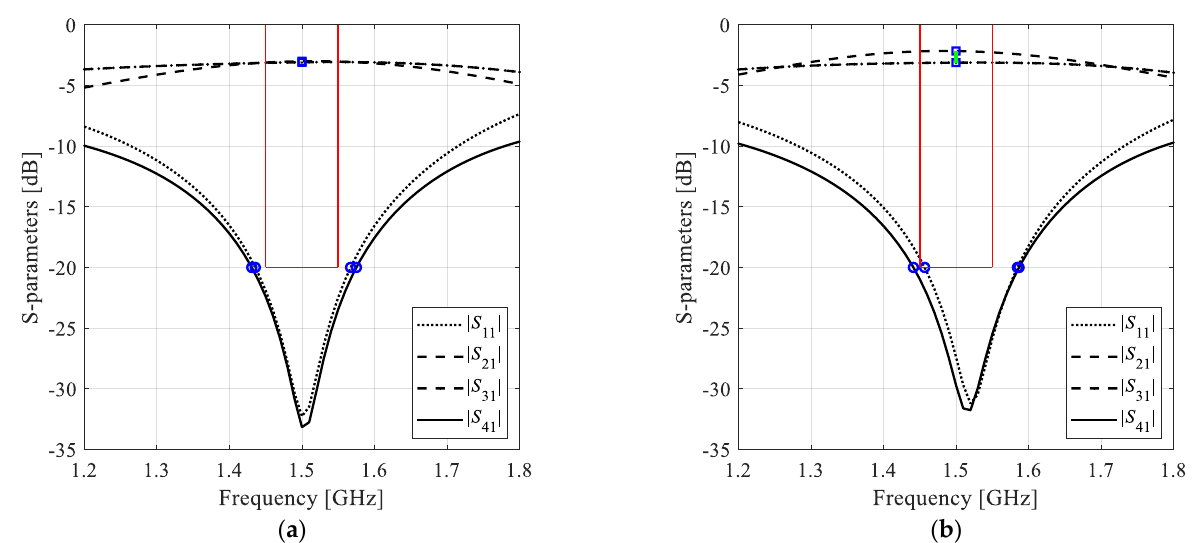
Figure 1. Scattering parameters of an exemplary microwave coupler along with the response features corresponding to –20 dB level of matching (| S 11 |) and isolation (| S 41 |) characteristics (o) and transmission (| S 21 |, | S 3 1 |) at the target operating frequency of 1.5 GHz ( ). The feature points allow for determining satisfaction of the performance requirements (here, the matching/isolation bandwidth of 1.45 GHz to 1.55 GHz, and maximum power split error of 0.5 dB at 1.5 GHz): ( a ) design satisfying specifications, ( b ) design violating both bandwidth and power split requirements.